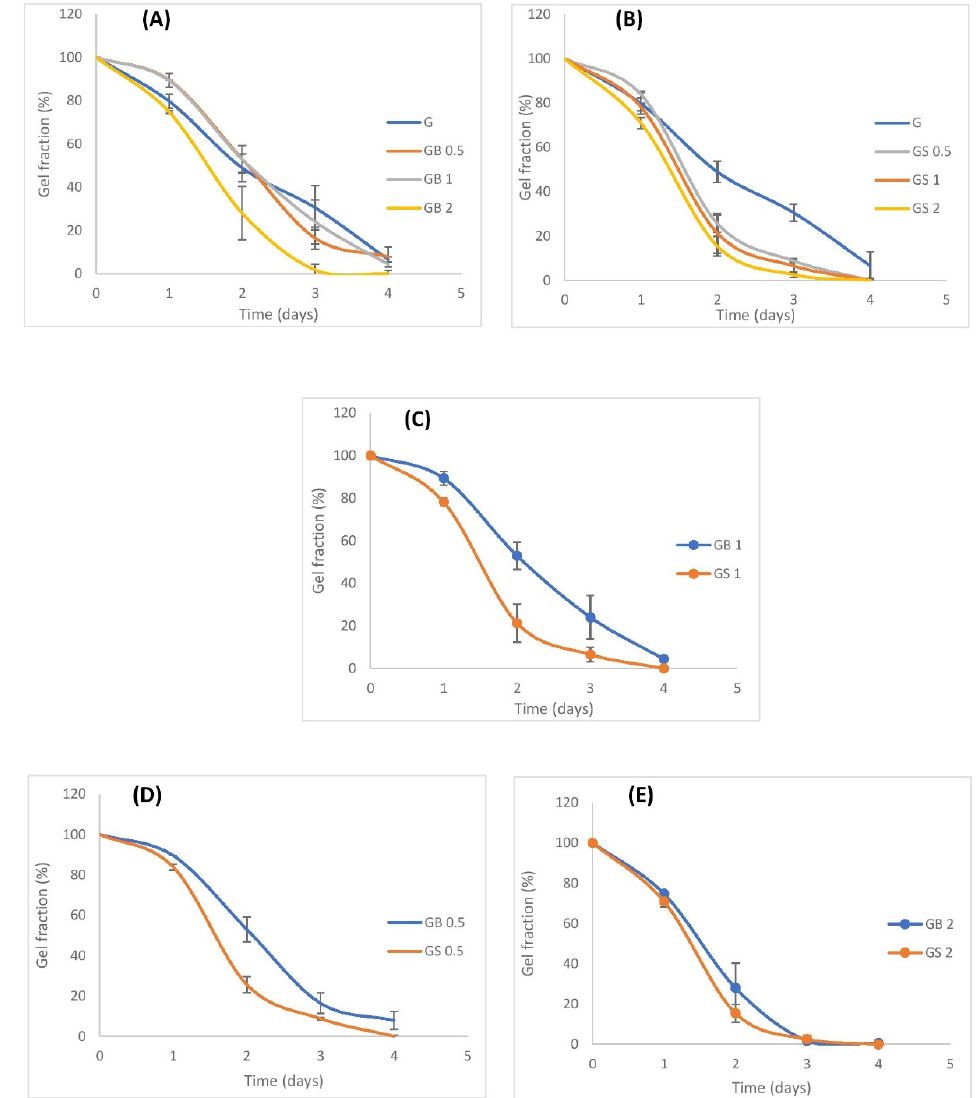
Figure 10. Degradation rates of hydrogel meshes in PBS (pH 7.4), ( A ) comparison of G with different concentrations (0.5%, 1%, 2%) of bovine collagen/GelMA hybrid meshes, ( B ) comparison of G with different concentrations (0.5%, 1%, 2%) of ovine collagen/GelMA hybrid meshes, ( C – E ) compare 0.5%, 1%, and 2% bovine and ovine collagen, respectively (**** p < 0.0001).